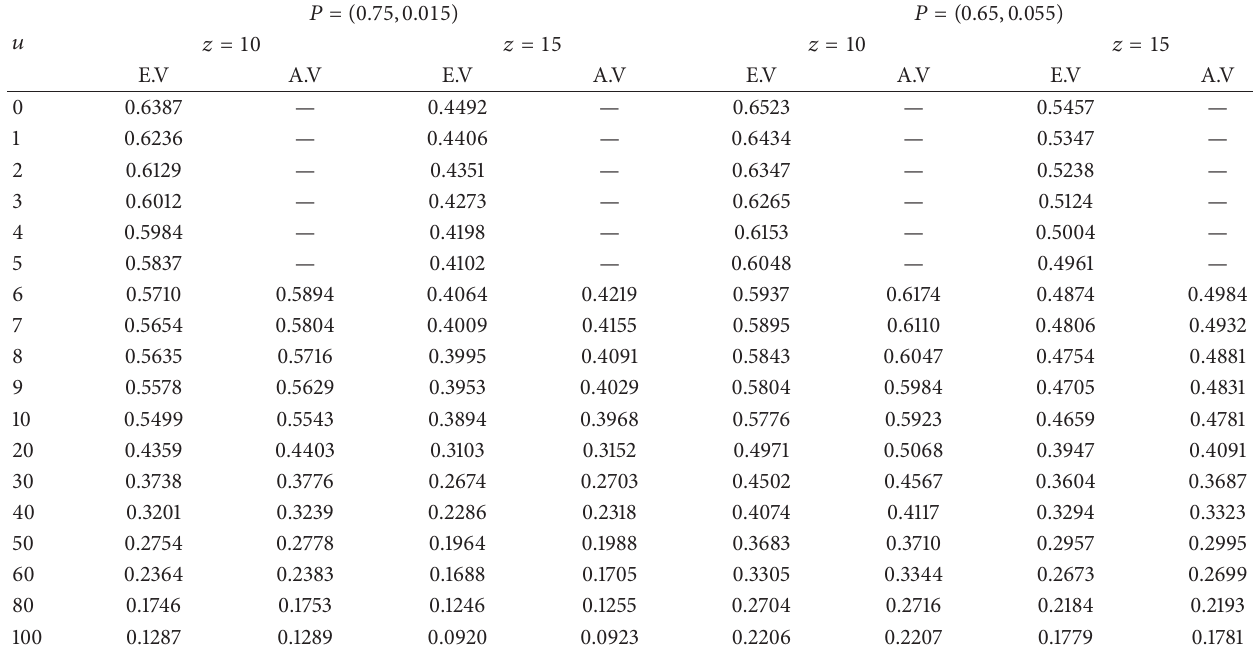
Table 3: Exact values and asymptotic values for the distribution function of the deficit at